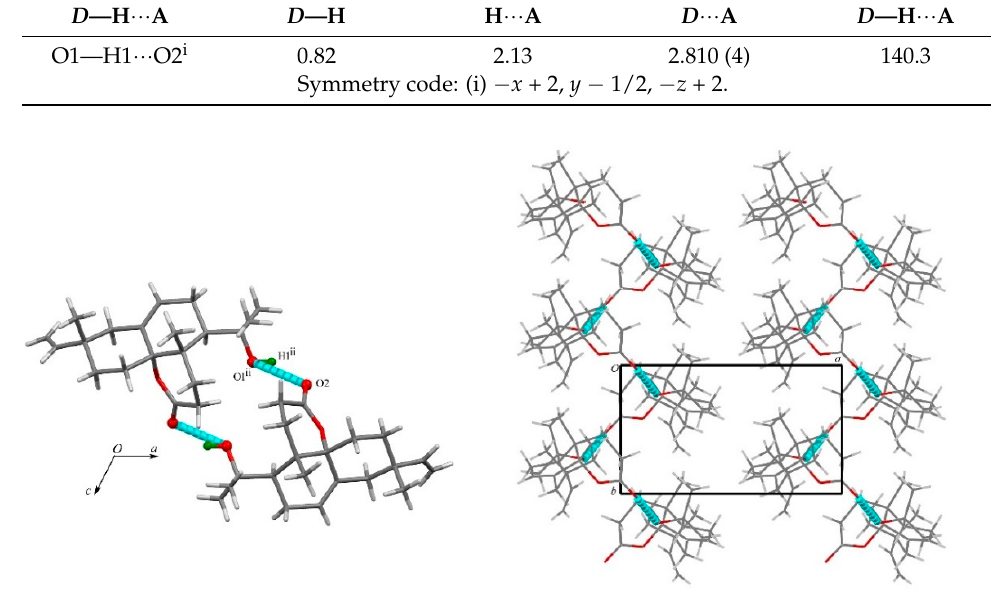
Figure 4. The crystal structure of 1 (hydrogen bonds shown as blue dashed lines). The view is along the b axis ( left ) and c axis ( right ). [Symmetry code: (ii) − x , 1/2 + y , − z .].